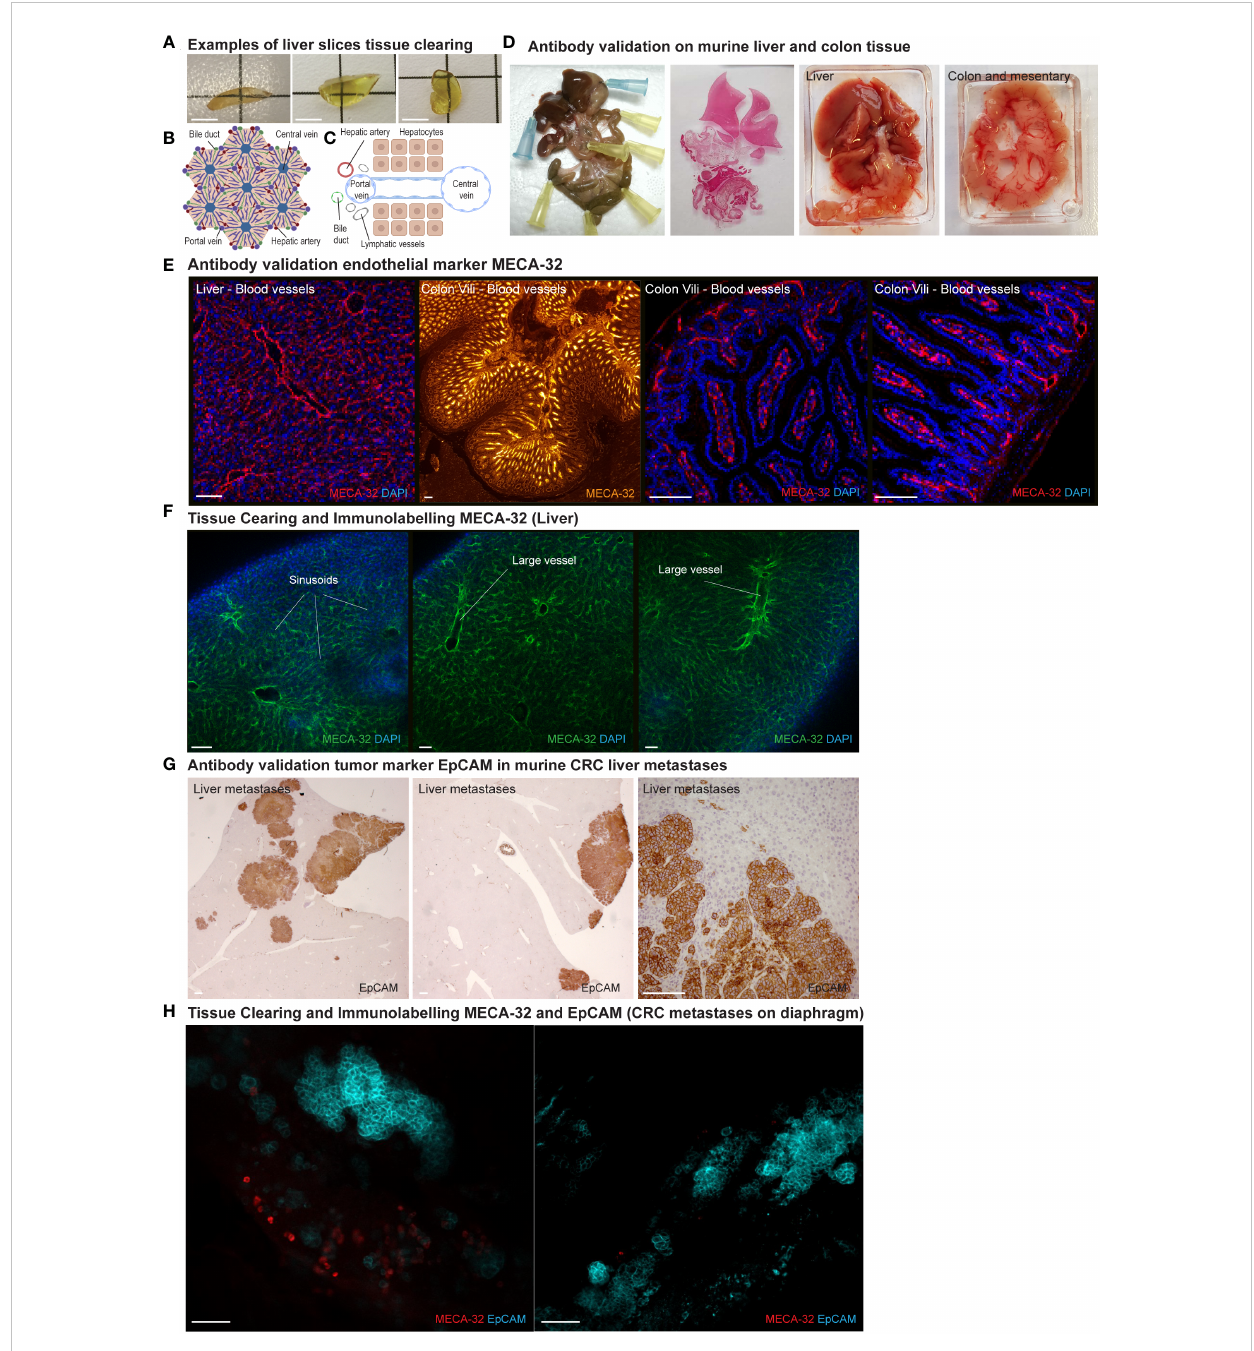
FIGURE 3 Tissue clearing: Vasculature and CRC tumor cells using 3DISCO/iDISCO. (A) Examples of transparency of liver samples after tissue clearing with the 3DISCO/iDISCO method. Scale bar = 5 mm (B, C) Structural organization of liver tissue and vasculature. (D) Tissue samples of murine liver and colon, used for antibody validation on tissue sections. (E) Antibody validation on liver and colon (vili) sections of pan-endothelial marker MECA-32 for blood vessel immunolabelling. DAPI (blue), MECA-32 (red and orange) Scale bar = 100 m m (F) . Visualization of blood endothelial microvasculature of the liver using endothelial marker MECA-32 (green). (DAPI in blue). MECA-32 showed speci fi c staining of the liver sinusoids and larger vessels. Scale bar = 100 m m (G) Antibody validation of tumor marker EpCAM in murine CRC liver metastases. Scale bar = 100 m m. (H) To use the model